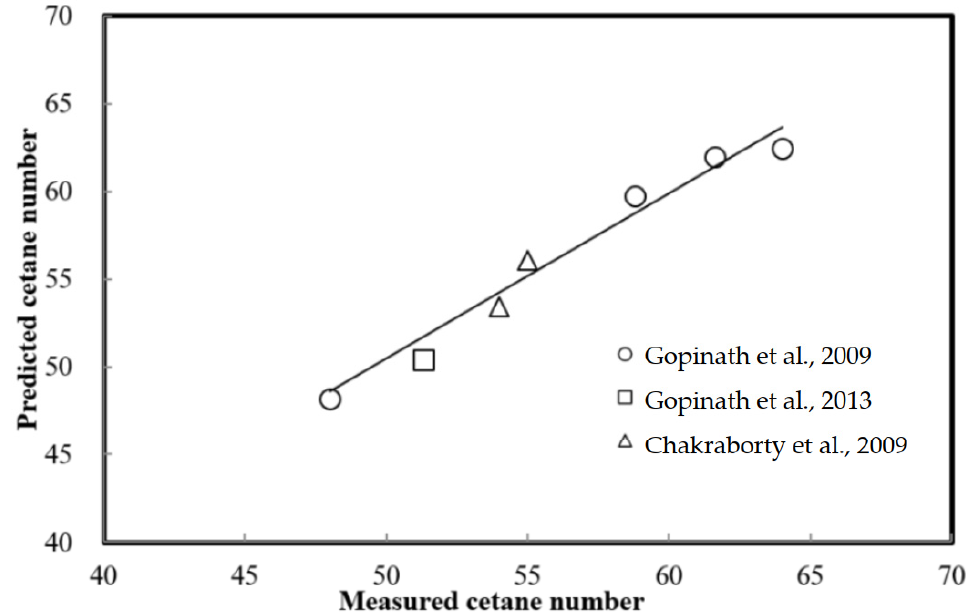
Figure 3. Verification for the proposed predictive formula in this study by the measured cetane number data available from